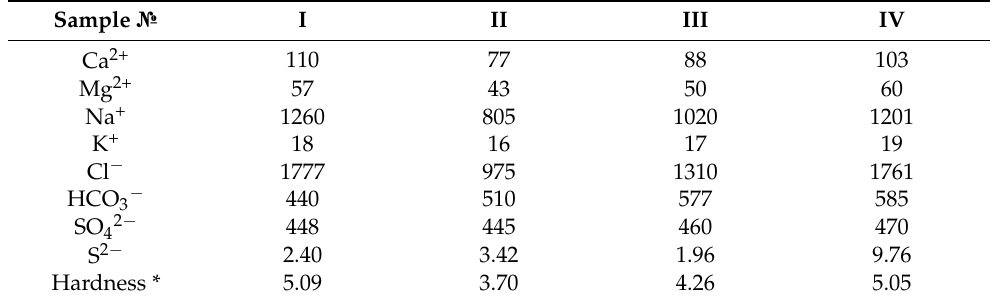
Table 2. Concentration (in mg/L) of macro- and meso-components of the produced water.